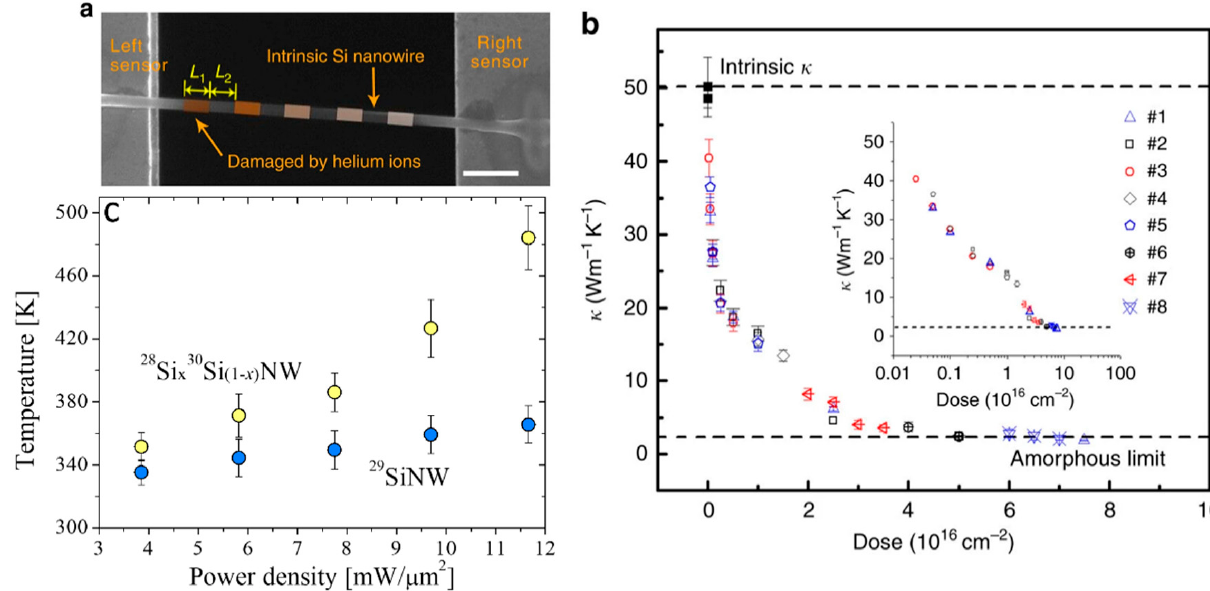
Figure 2. Phonon engineering in nanowires. ( a ) SEM image of a Si NW damaged by helium ions (sample #1). The portions colored orange denote the parts damaged by helium ions; the uncolored portions denote the intrinsic Si NW. Scale bar, 1 mm. ( b ) Measured k of samples #1–#8 versus dose. Inset: the same data plotted on a logarithmic scale. The solid black square denotes the k of intrinsic NWs (namely, with zero dose). ( c ) Plot of the measured power density as a function of the laser heating for different isotopically engineered Si NWs. ( a , b ) Reproduced with permission from [56]. Copyright Springer Nature, 2017. ( c ) Adapted from Mukjerjee et al. [57].